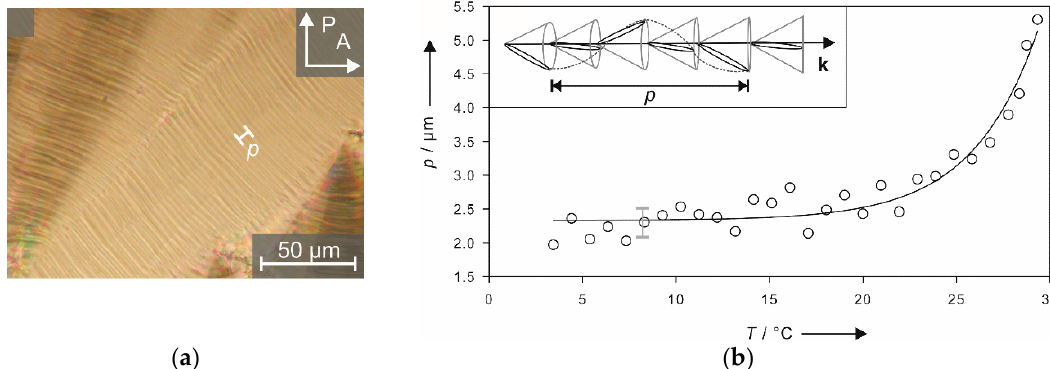
Figure 12. The striped texture shown in ( a ) originates from a helical precession of the tilt direction along the layer normal k which is depicted in the inset of ( b ). The distance necessary for a full rotation of the director corresponds to the helical pitch p , which is plotted versus the temperature T in ( b ). (Reprinted by permission from John Wiley and Sons: [29].)